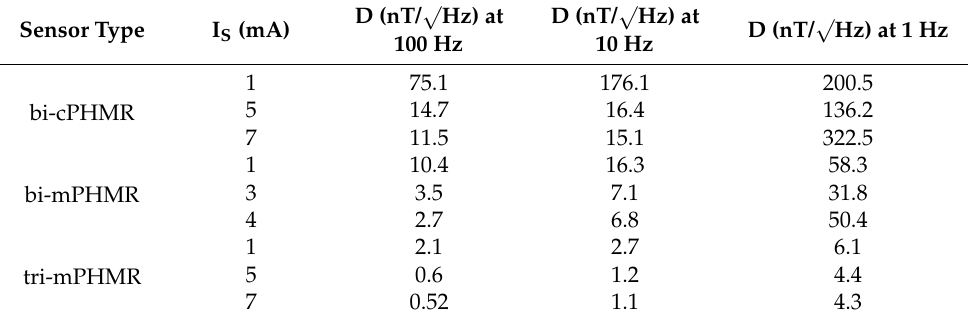
Table 4. Detectivity for PHMR sensors for different sensing currents in CC